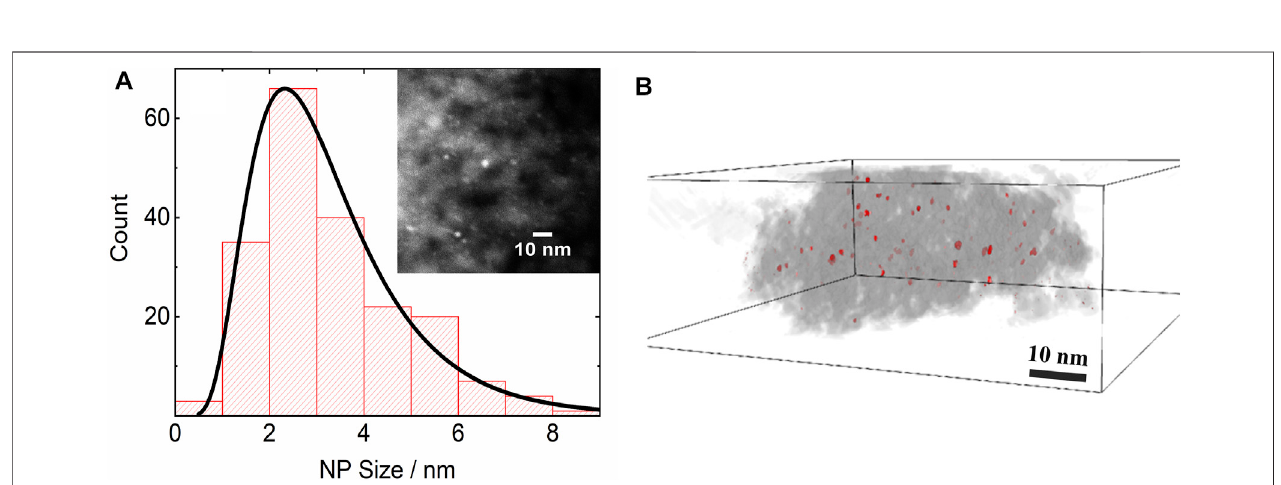
FIGURE 6 | (A) Size distribution histogram of the Pt NPs determined via STEM images (measurement of the diameter of 200 Pt particles) in MonoCat-1. (B) TEM tomography visualizing the reconstructed 3D model of Pt NPs embedded in the support material.